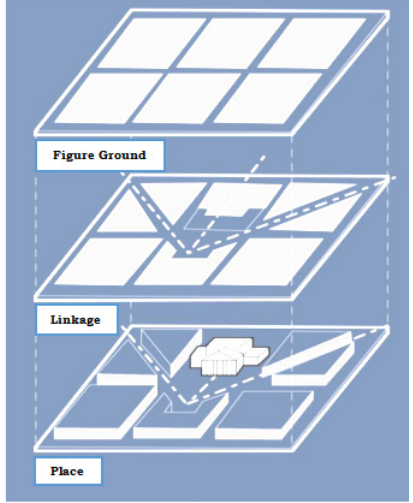
Figure 1. Diagram of urban design